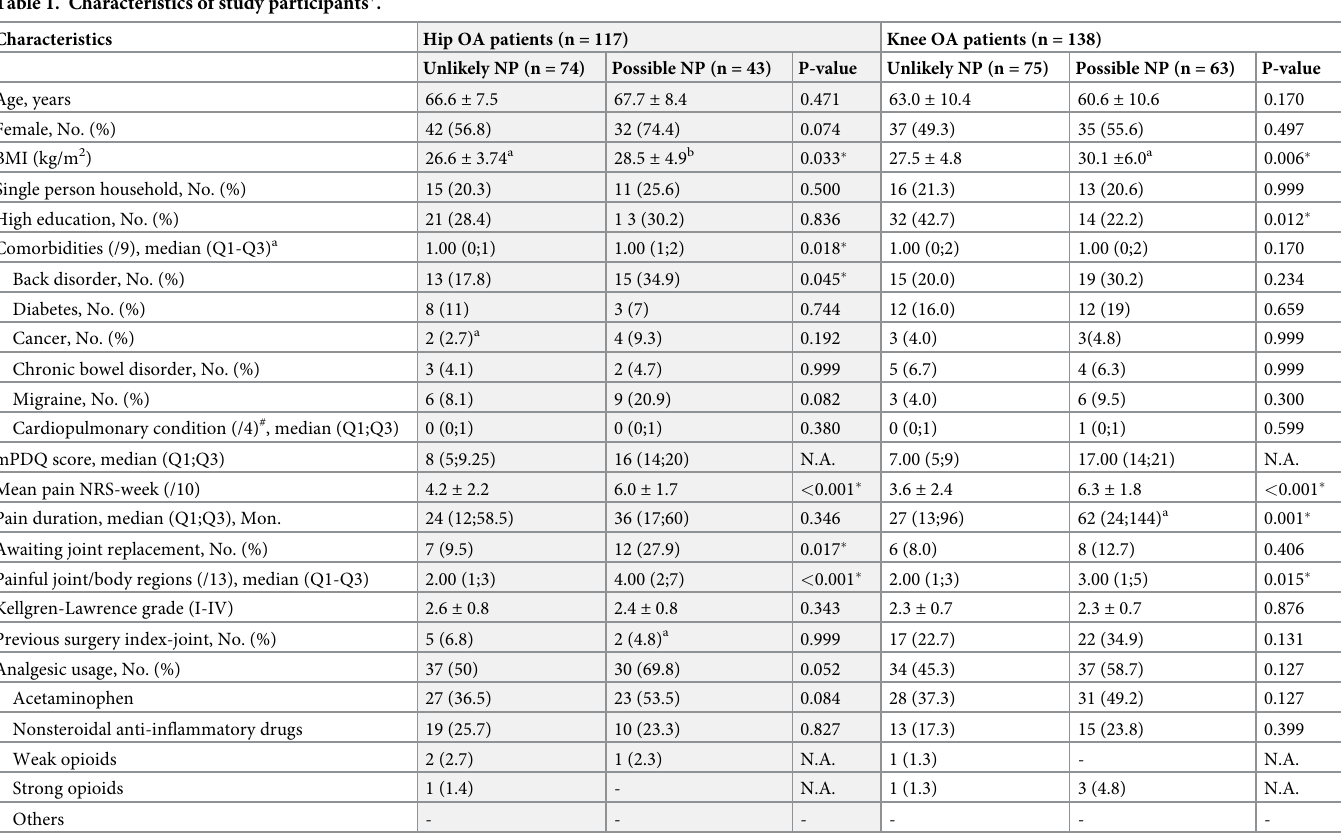
Table 1. Characteristics of study participants †